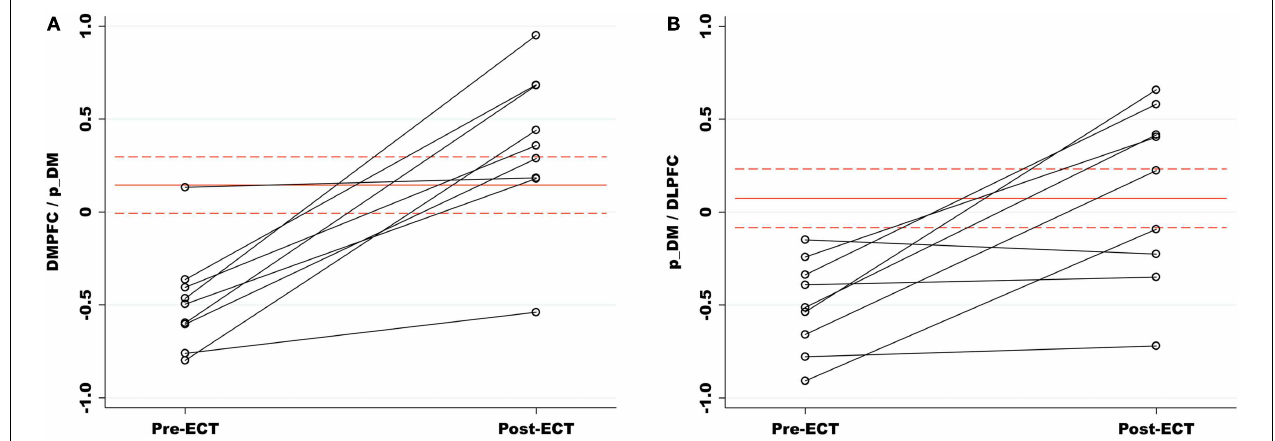
FIGURE 3 | (A) Functional network connectivity (FNC) increased between the p_DM and DMPFC pre- to post-ECT. FNC correlations are represented on the y -axis.The red lines (dashes) are the means (standard errors) of the matched healthy comparison FNC correlations. Relative to healthy comparisons, the